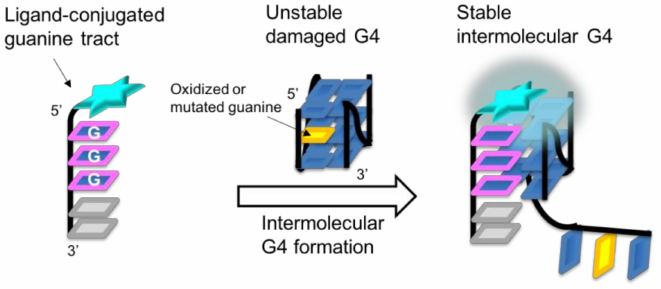
Figure 1. Schematic illustration of the recovery of mutated VEGF G4 by intermolecular G4 formation using a ligand-conjugated guanine